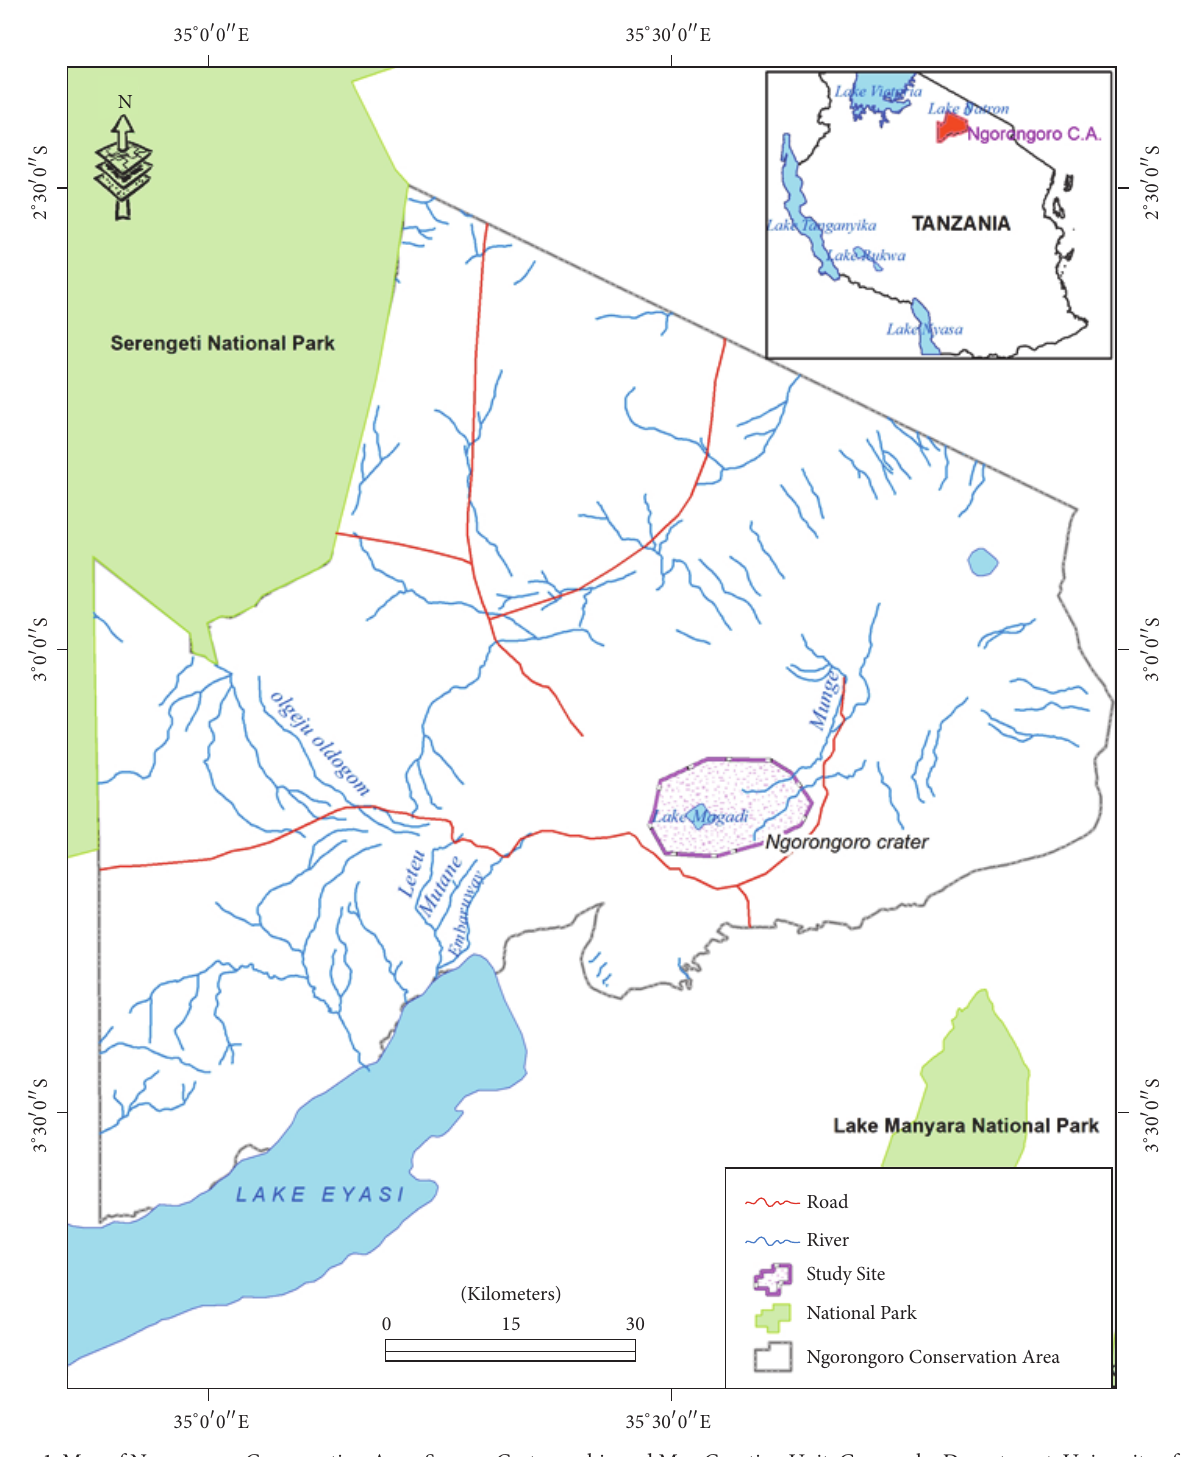
Figure 1: Map of Ngorongoro Conservation Area. Source: Cartographic and Map Curating Unit, Geography Department, University of Dar es Salaam,